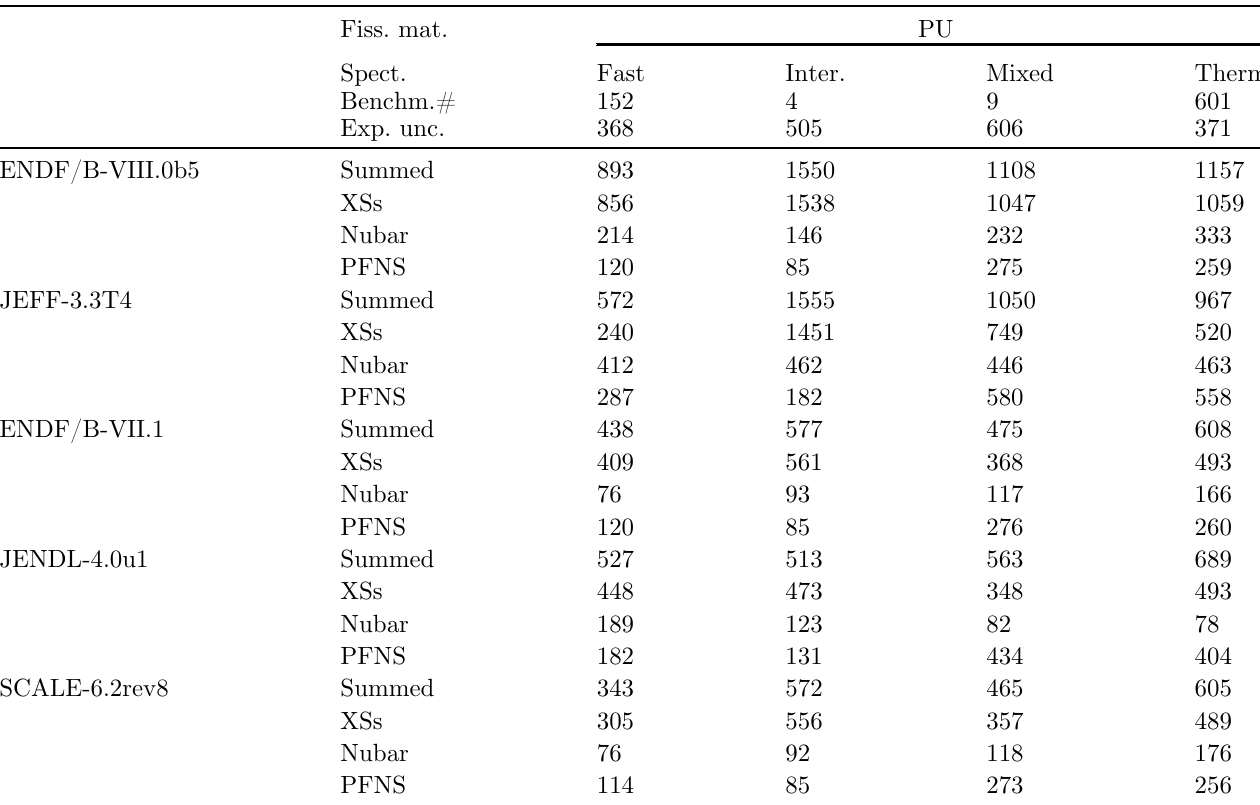
Table 3. Impact of different 239 Pu nuclear data covariances in ICSBEP suite averaged for fi ssile material and spectrum. Fiss. mat. PU Spect. Fast Inter. Mixed Therm.